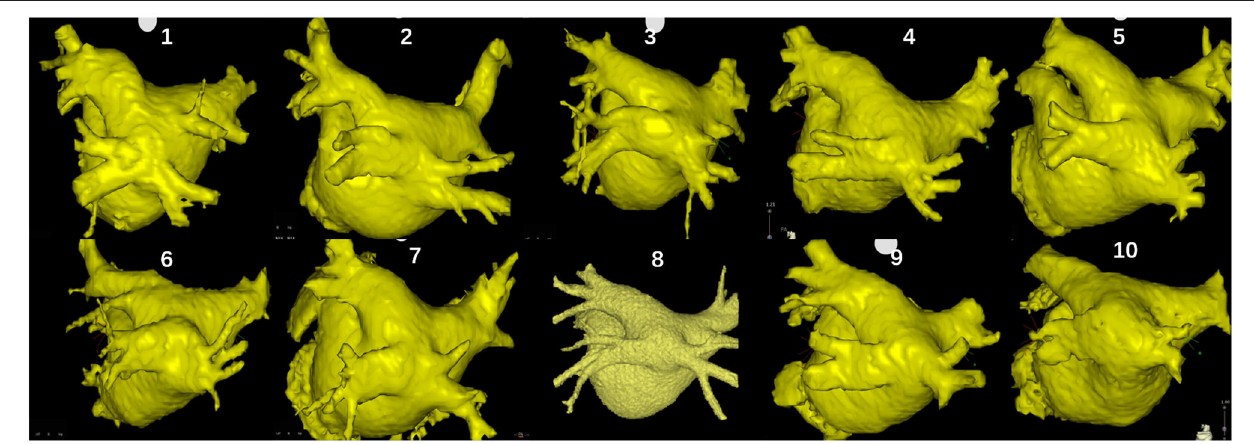
FIGURE 1 | Three-dimensional computer tomography images of the left atrium and pulmonary veins (PVs) of the 10 patients.